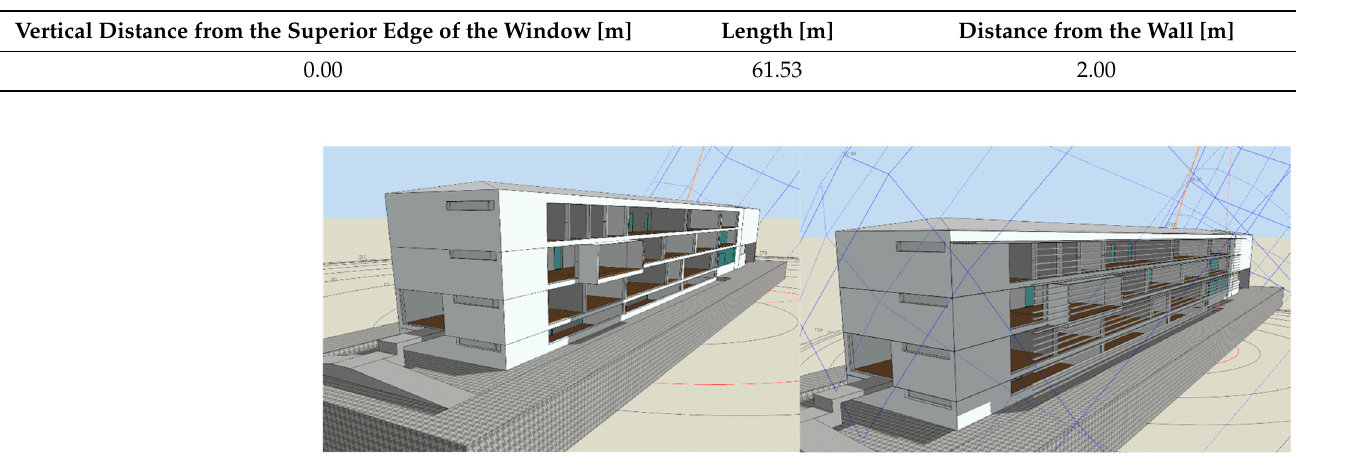
Figure 3. Rendered view of the façade; with ( right ) and without ( left ) solar control for the summer design day (Time: 13:00 h).